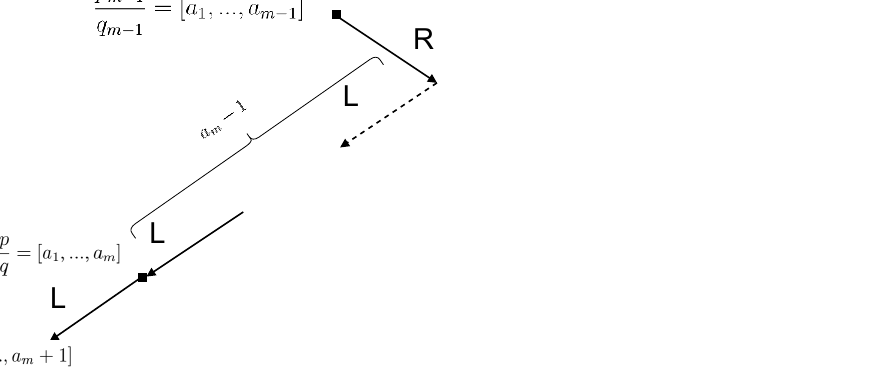
Figure A2. Diagram of the construction for the left descendant of G p / q , where p / q = [ a 1 , . . . , a m ] . The left descendant is expressed as [ a 1 , . . . , a m + 1 ] and is obtained by concatenating G p G p / q , where p m − 1 / q m − 1 is the convergent of order m − 1 of p / q